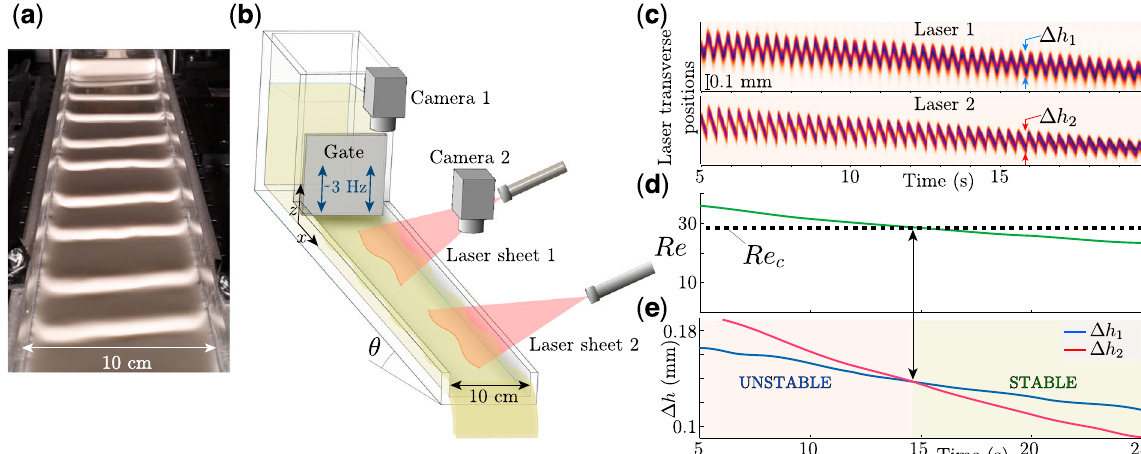
Fig. 1 Experimental characterization of the instability onset. a Non-inertial surface waves emerging spontaneously when a concentrated suspension of cornstarch particles fl ows down an incline (volume fraction ϕ = 0.45, inclination angle θ = 10 ∘ and normalized fl ow Reynold number Re / Re K ≈ 0.2). b Sketch of the experimental setup. We use the progressive drainage of the reservoir to quasi-steadily vary the fl ow rate. The instability onset is determined by measuring the wave amplitudes both at the top and at the bottom of the incline with two laser sheets and cameras. For ϕ ≤ 0.4, an oscillation of the gate is added to impose a controlled perturbation. c Spatiotemporal plots of the laser sheet transverse-position versus time, indicating the vertical oscillations (blue and red arrows) of the free surface, at the top and at the bottom of the incline ( ϕ = 0.33, θ = 2 ∘ , Re ≈ 37). d Reynolds number of the fl ow, Re , and e amplitude of the perturbation at the top, Δ h 1 , and at the bottom, Δ h 2 , during the drainage of the suspension reservoir ( ϕ = 0.36, θ = 3 ∘ ). The instability onset ( Δ h 1 = Δ h 2 ) is given by Re c ≈ 28